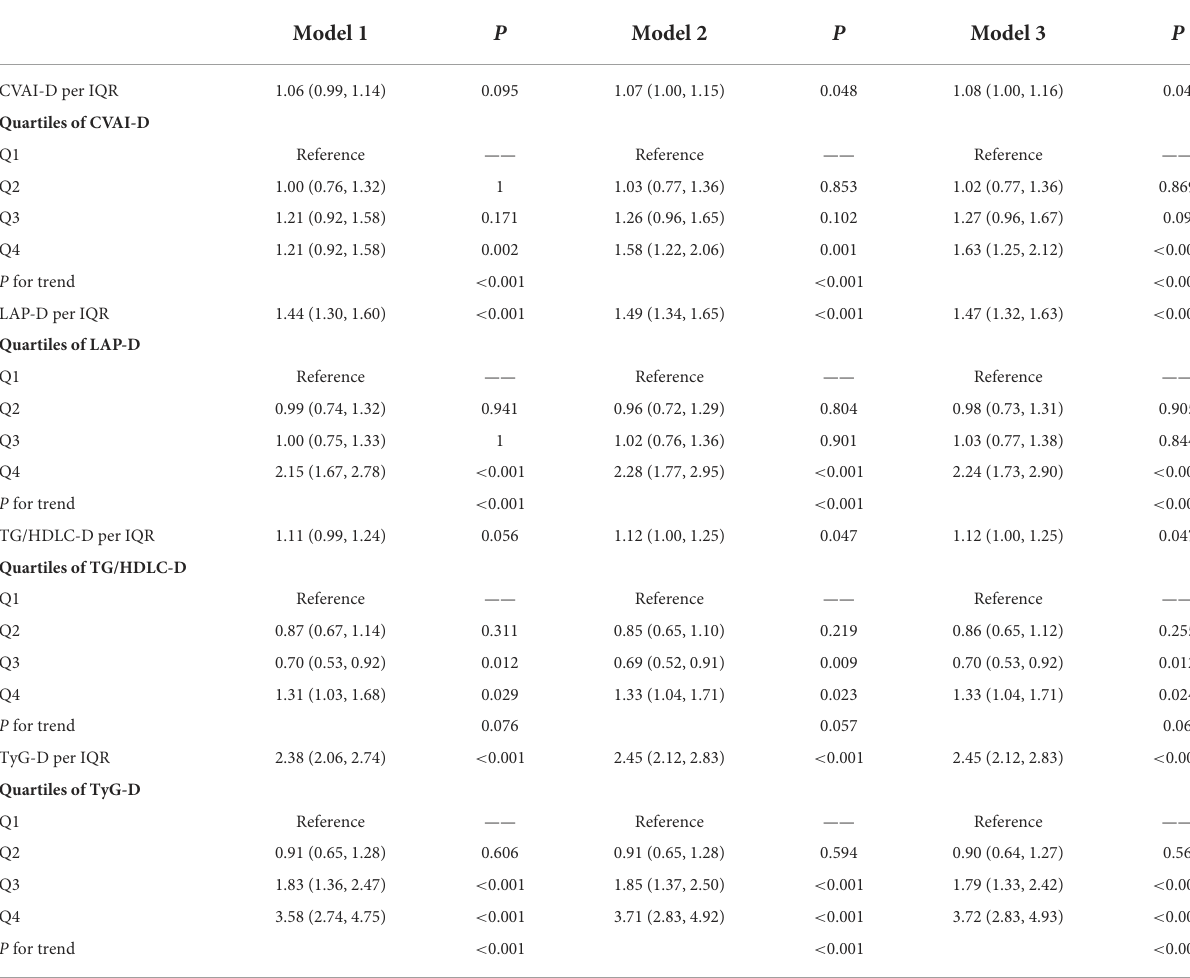
TABLE 2 Association between four surrogate indexes and T2DM